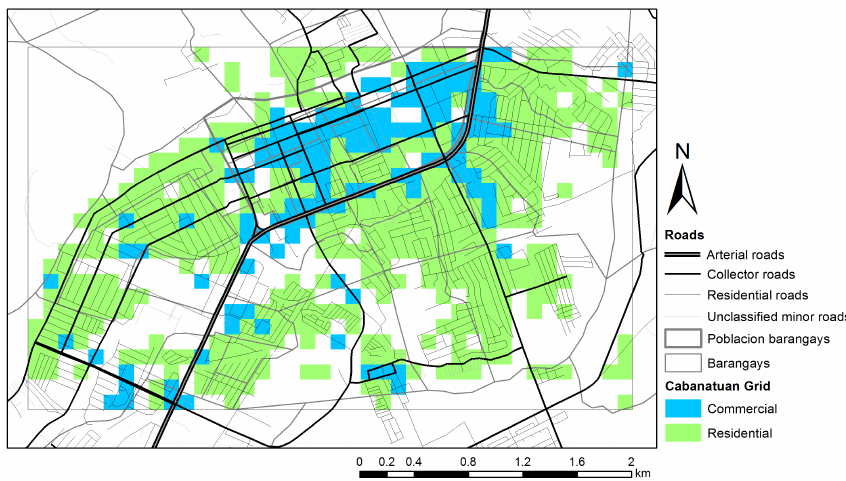
Figure 2. The 2 . 4 × 4 . 0km study area in Cabanatuan containing the “city center” ( poblacion , highlighted). Base map derived from satellite imagery (Google Earth Pro, 2015, 2016). Additional data from OpenStreetMap (OpenStreetMap contributors, 2016).